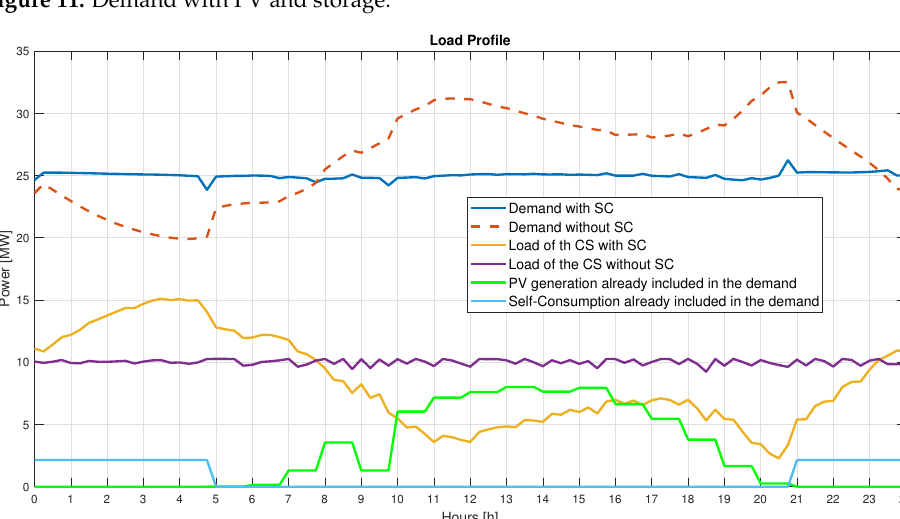
Figure 12. New demand with PV and storage.